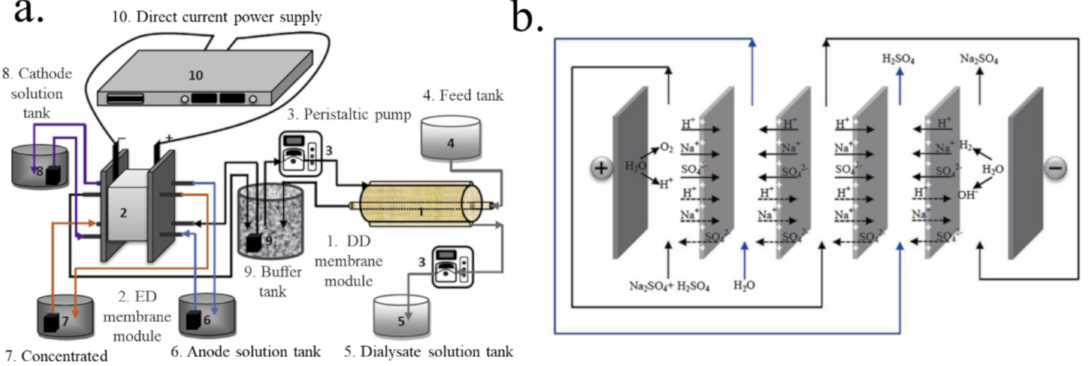
Figure 9. Flow chart of experimental apparatus ( a ). The schematic representation of the ED assisted DD stack ( b )